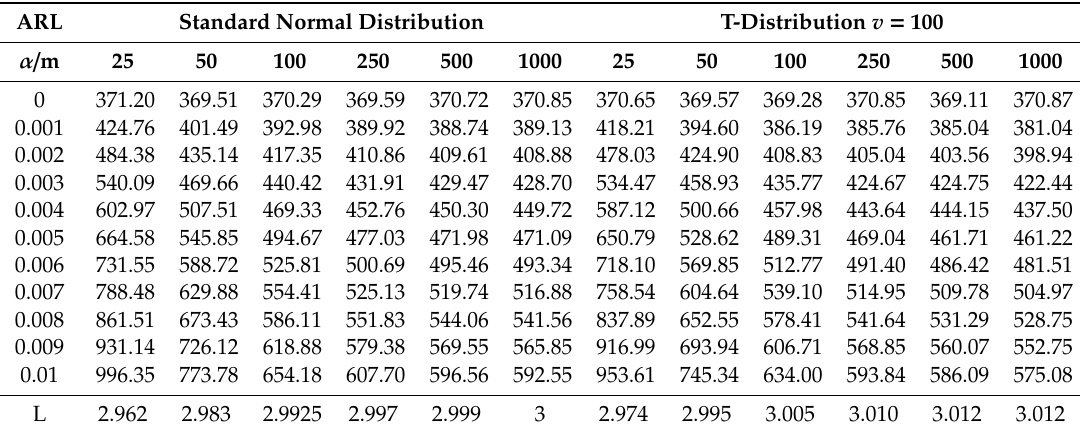
Table 3. ARL of the Shewhart chart in the presence of outliers with estimated parameters for standard normal and t ( v = 100) distributions.